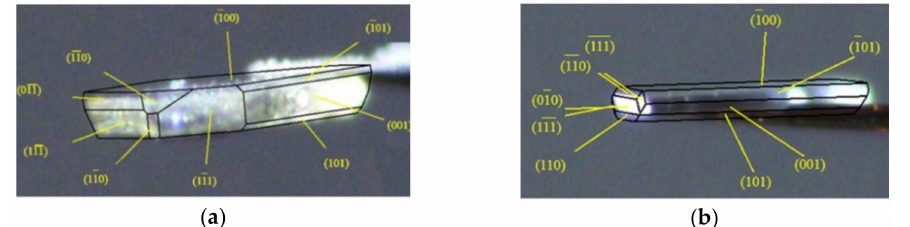
Figure 4. Face indexation data of ( a ) ST-A and ( b ) ST-B.